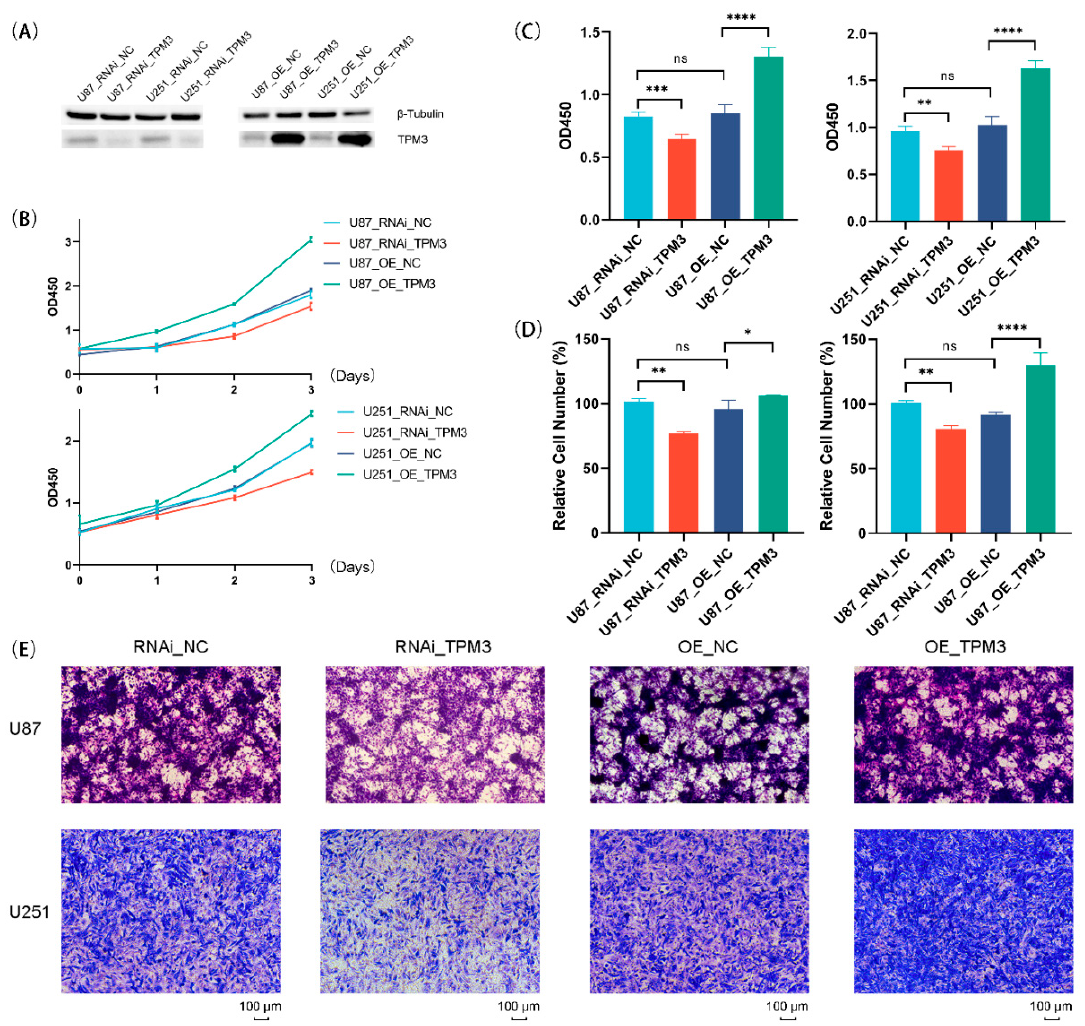
Figure 12. Correlations between TPM3 overexpression/knockdown and biological characterizations of U87 and U251 cells. ( A ) Western blot analyses were carried out to confirm the overexpression or knockdown efficiency of TPM3. ( B ) The growth curves of U87 cells and U251 cells with or without TPM3 overexpression/knockdown. ( C ) The proliferation ability of U87 cells and U251 cells quantified by Brdu assay. ( D ) Quantification of the Transwell assay. ( E ) Migration ability of U87 and U251 cells employed by Transwell migration assay. (ns, no significance; *, p < 0.05; **, p < 0.01; ***, p < 0.001; ****, p <